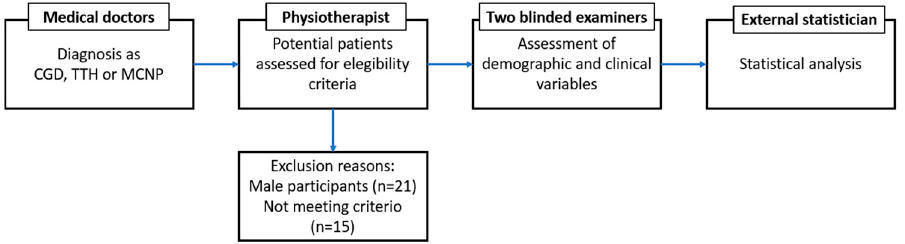
Figure 1. Procedure: Research timeline .